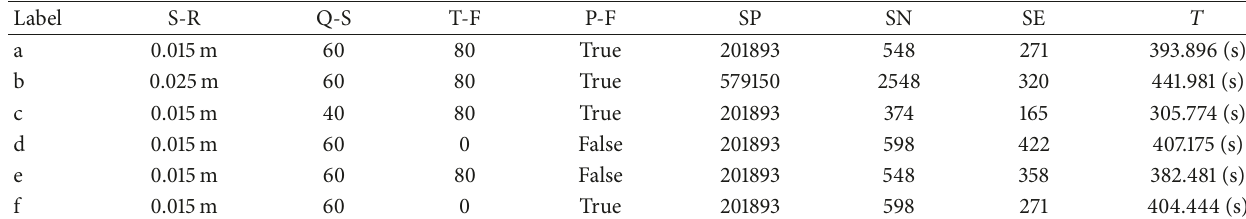
Table 3: Parameters and results of generating skeleton of the toona